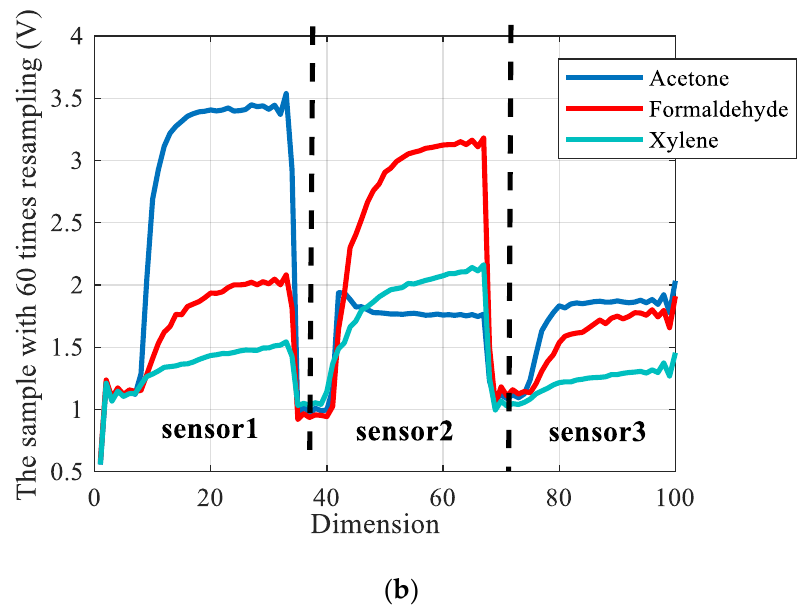
Figure 3. The original sample and the sample with 60 times resampling. ( a ) The original sample; ( b ) The sample with 60 times resampling.